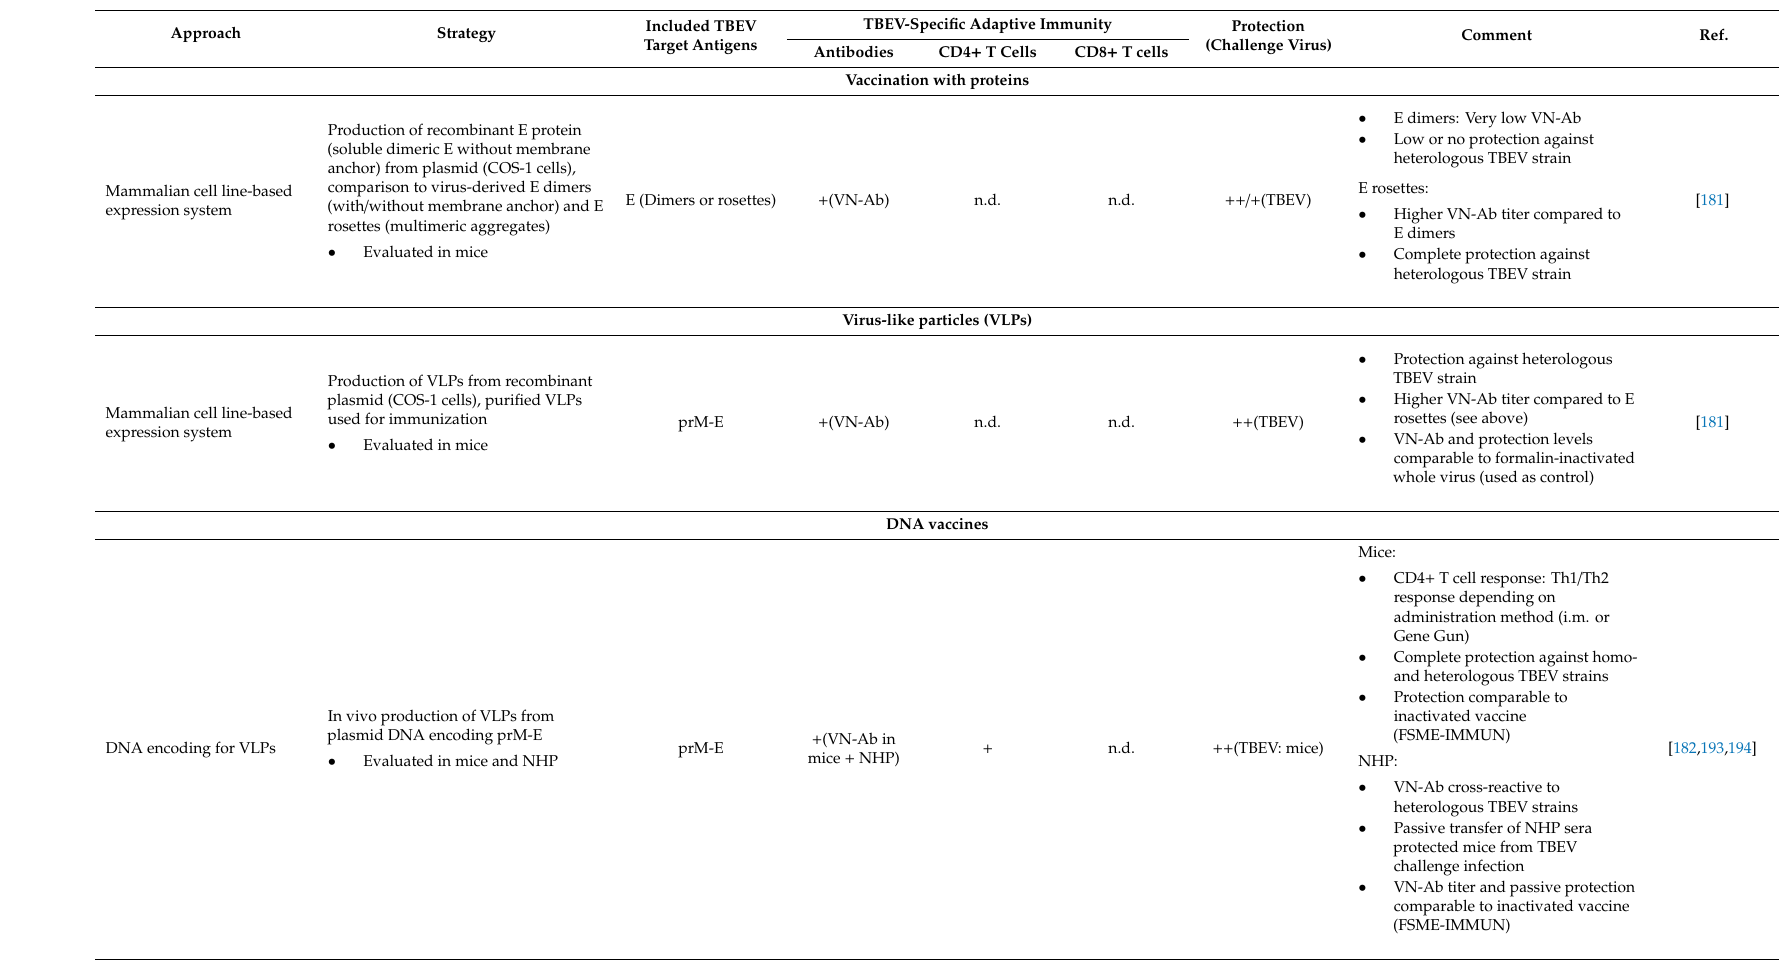
Table 3. In vivo evaluated approaches for TBEV vaccine candidates and their